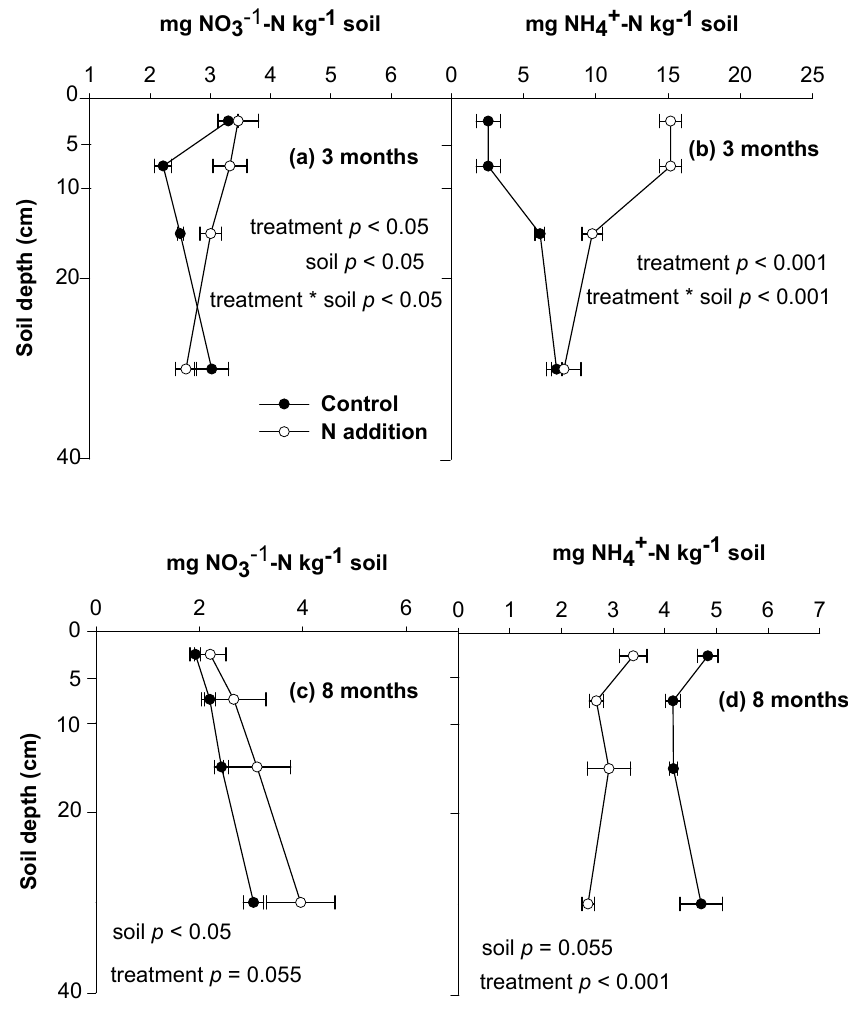
Figure 3. ( a ) Concentration of soil indigenous NO 3 − (mean ± standard error (se); n = 8) three months after N addition. ( b ) Concentration of soil indigenous NH 4+ (mean ± se; n = 8) three months after N addition. ( c ) Concentration of soil indigenous NO 3 − (mean ± se; n = 5) eight months after N addition. ( d ) Concentration of soil indigenous NH 4+ (mean ± se; n = 5) eight months after N addition. Data are graphed at the mid-point of our soil sampling